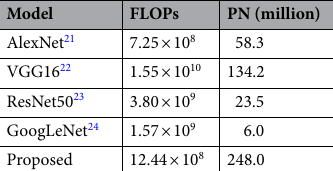
Table 1. Comparisons of model size and complexity. FLOPs floating point operations, PN the number of trainable parameters.